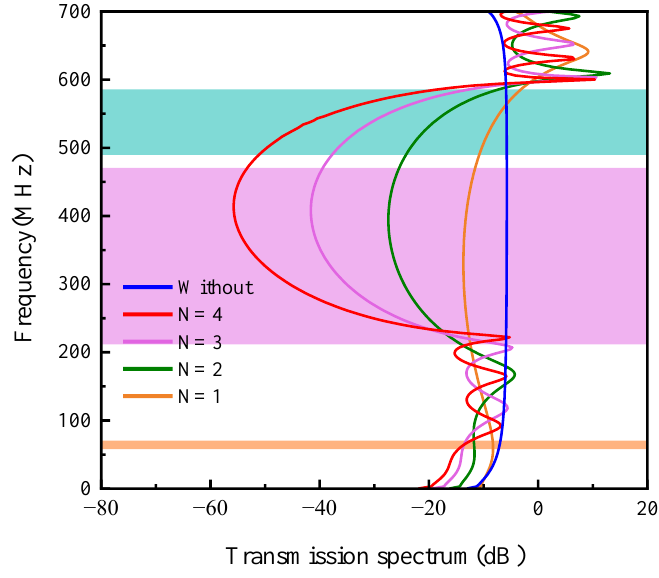
Figure 4. H-RPC frequency response curve.